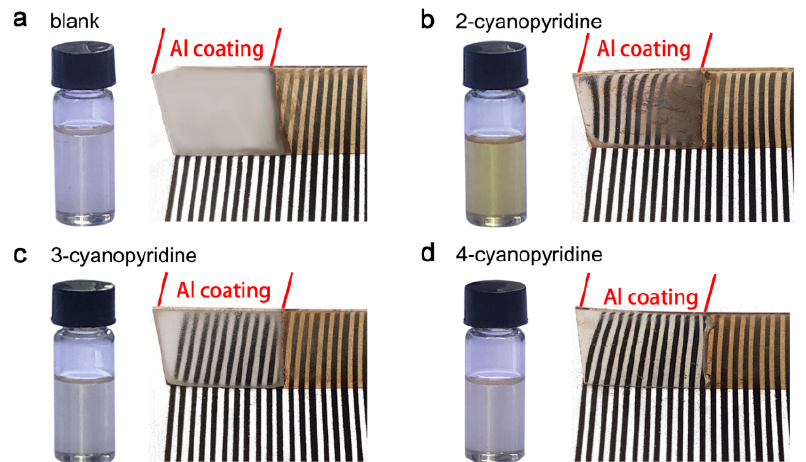
Figure 3. Appearance of AlCl 3 -EMIC ionic liquids and photographs of Al coatings on the Cu substrate electrodeposited at 10 mA/cm 2 for 30 min from solutions containing ( a ) no and 6 mM of ( b ) 2-cyanopyridine, ( c ) 3-cyanopyridine, and ( d ) 4-cyanopyridine.